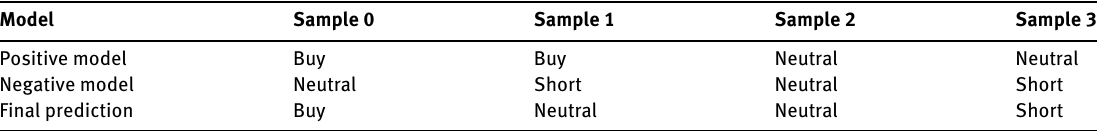
Table 2: One-vs-All Approach for Language Model Predictions.